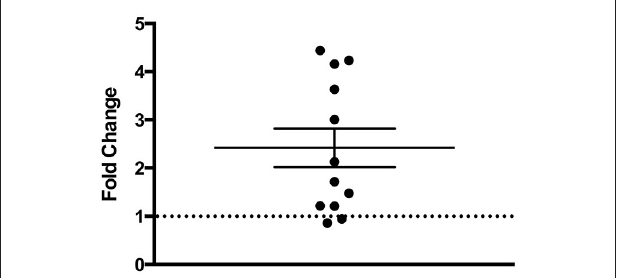
preference test compared to the initial preference test ( p < 0.005). Individual data points are plotted with the Mean ± SEM. The dashed line at 1 indicates no fold